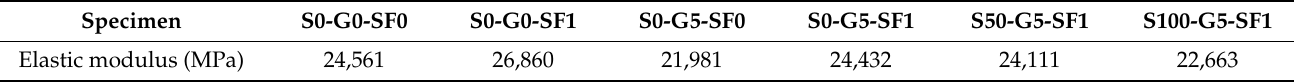
Table 7. Results of the elastic modulus.